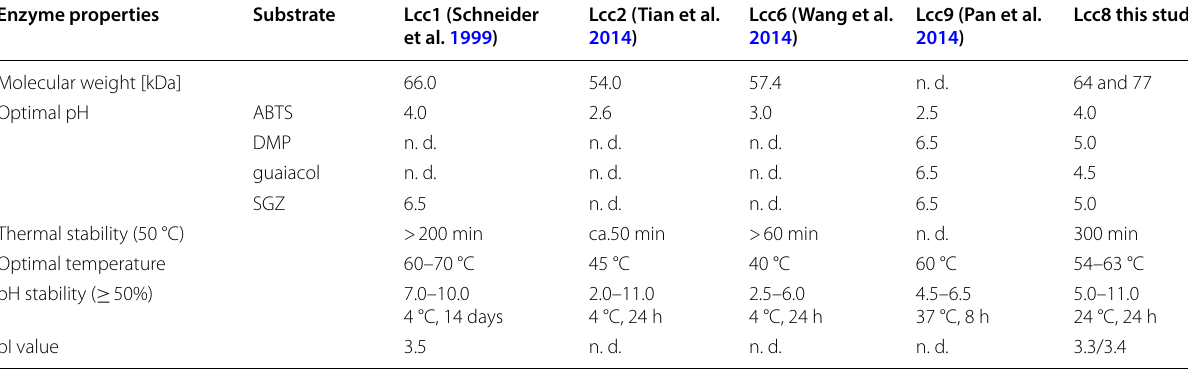
Table 2 Comparison of properties of different C. cinerea laccases Enzyme